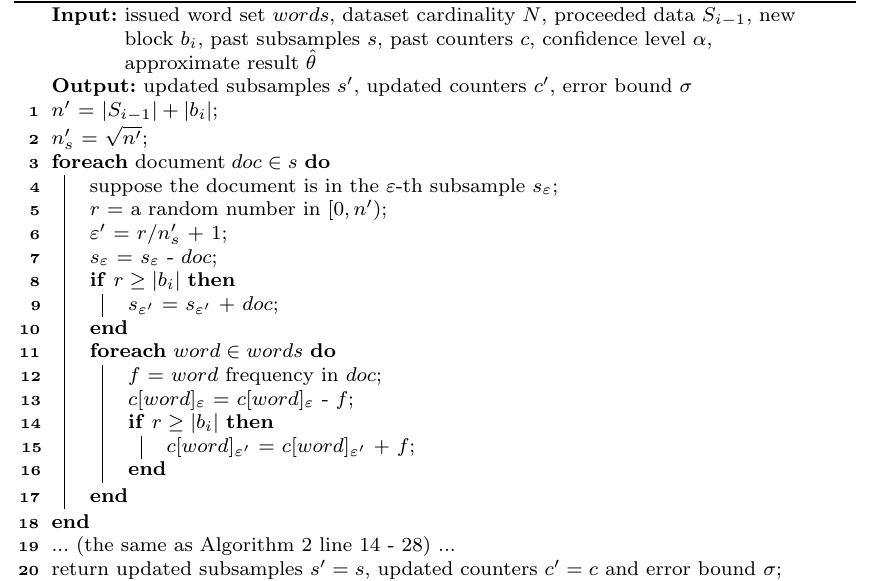
Algorithm 3: Progressive Bootstrap with